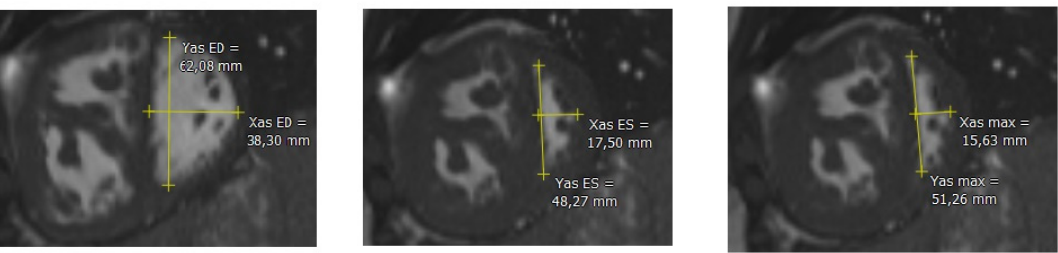
Figure 2. Left image: eccentricity index of the left ventricle at end-diastole. Middle image: eccentricity index of the left ventricle at end-systole. Right image: maximum eccentricity index of the left ventricle at end-systole. Yas ED: diameter parallel to the IVS at end-diastole; Xas ED: diameter perpendicular to the IVS at end-diastole; Yas ES: diameter parallel to the IVS at end-systole; Xas ES: diameter perpendicular to the IVS at end-systole; Yas max: diameter parallel to the IVS at end-systole with septal bulging; Xas max: diameter perpendicular to the IVS at end-systole with septal bulging. IVS: intraventricular septum.